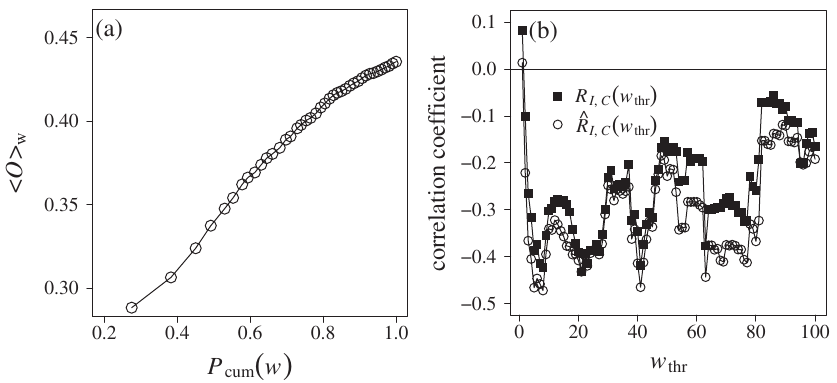
FIG. 7. (a) Averaged neighborhood overlap h O i w as a function of the fraction of links with weights smaller than w for D correlation coefficient between I i and C i ð w fixed (circles), for D